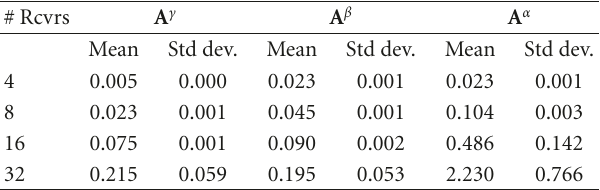
Table 1: Average HPB execution time